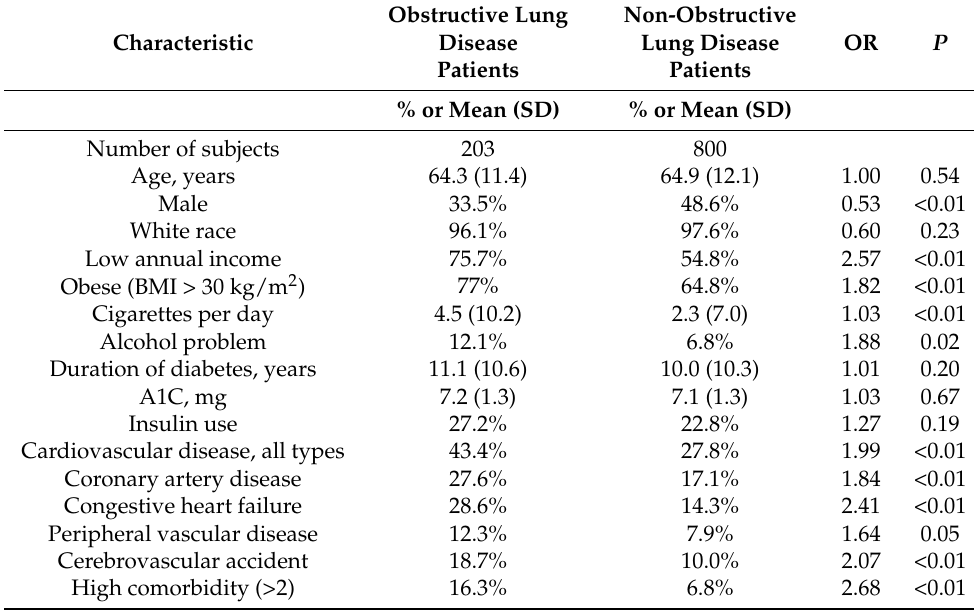
Table 2. Univariate associations between obstructive lung disease and other patient characteristics.